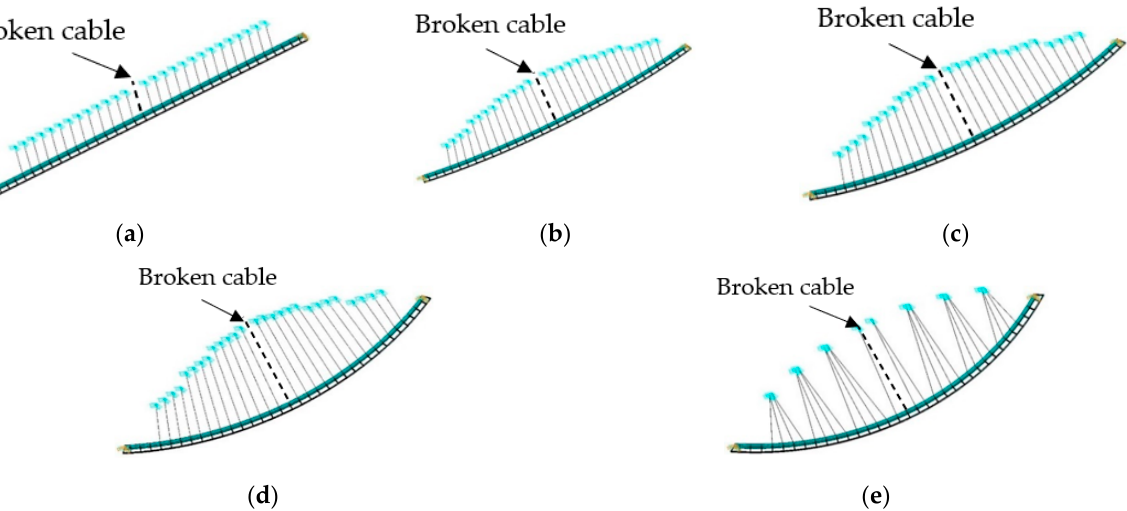
Figure 3. Diagram of curvature cases: ( a ) Curvature case 1( k = 0.0000); ( b ) Curvature case 2 ( k = 0.0024); ( c ) Curvature case 3 ( k = 0.0048); ( d ) Curvature case 4 ( k = 0.0072); and ( e ) Curvature case 5 ( k = 0.0097).